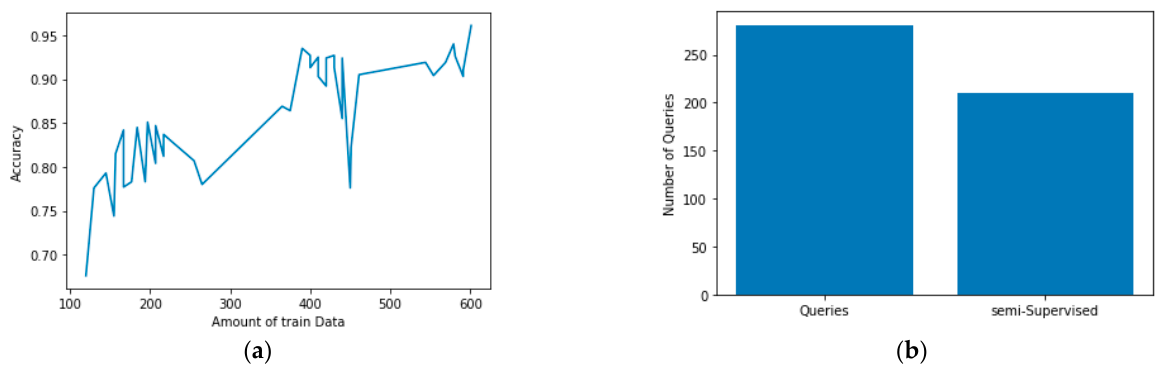
Figure 7. ( a ) Accuracy graph of convolutional neural network (CNN) based models; ( b ) Number of semi-supervised active transfer learning (SATL) queries for CNN based models. Table 7. Convolution neural networks based basic model.